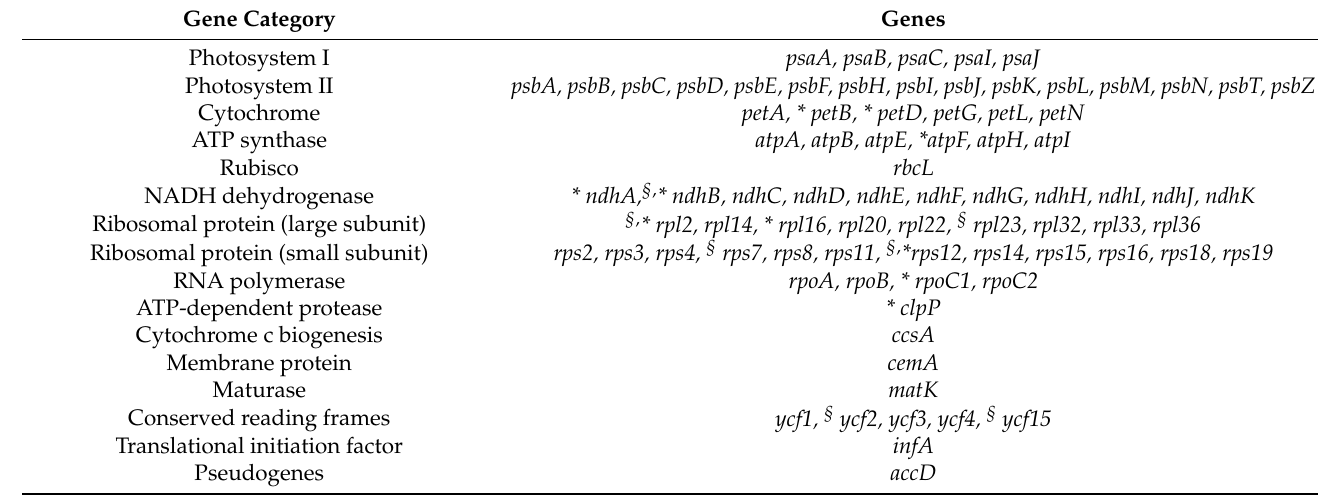
Table 2. The summary of chloroplast coding genes in